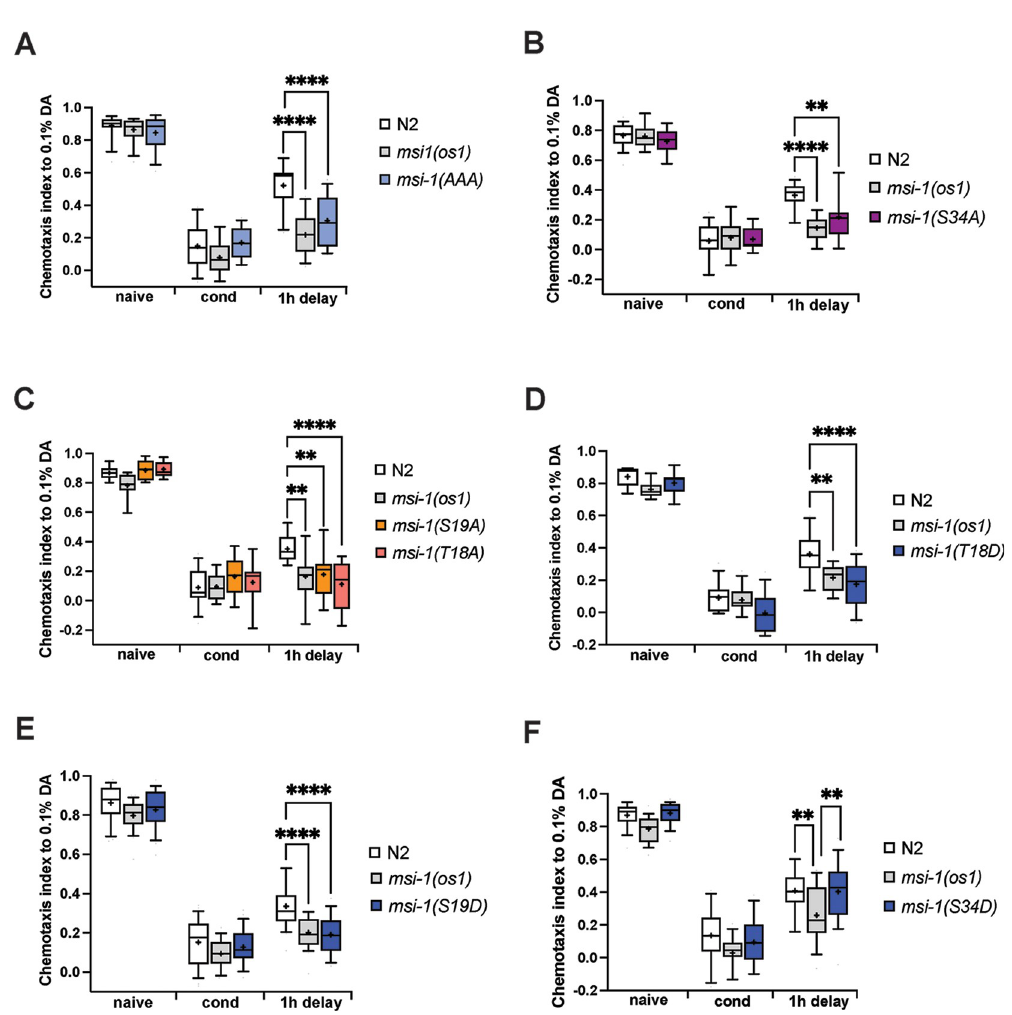
Fig 3. Short-term memory phenotyping of msi-1 phospho-mutants. Negative olfactory STAM was tested in WT, msi-1 (os1) and animals with phospho-inhibitory (A-C) or phospho-mimetic (D-F) mutations as indicated. Worms were assayed toward 1:1000 diluted DA before (naive), directly after conditioning (cond) or followed by a 1-hour recovery phase (1h delay). All experiments were done in triplicates and repeated at least four times. Data is represented in boxplots with 10 and 90 percentile whiskers. Significance was tested with 2-way ANOVA and post hoc t-tests across all conditions. ns = not significant, asterisks represent Bonferroni-corrected p-values: � = p < 0.05, �� = p < 0.01 ��� = p < 0.001 and ���� = p < 0.0001.